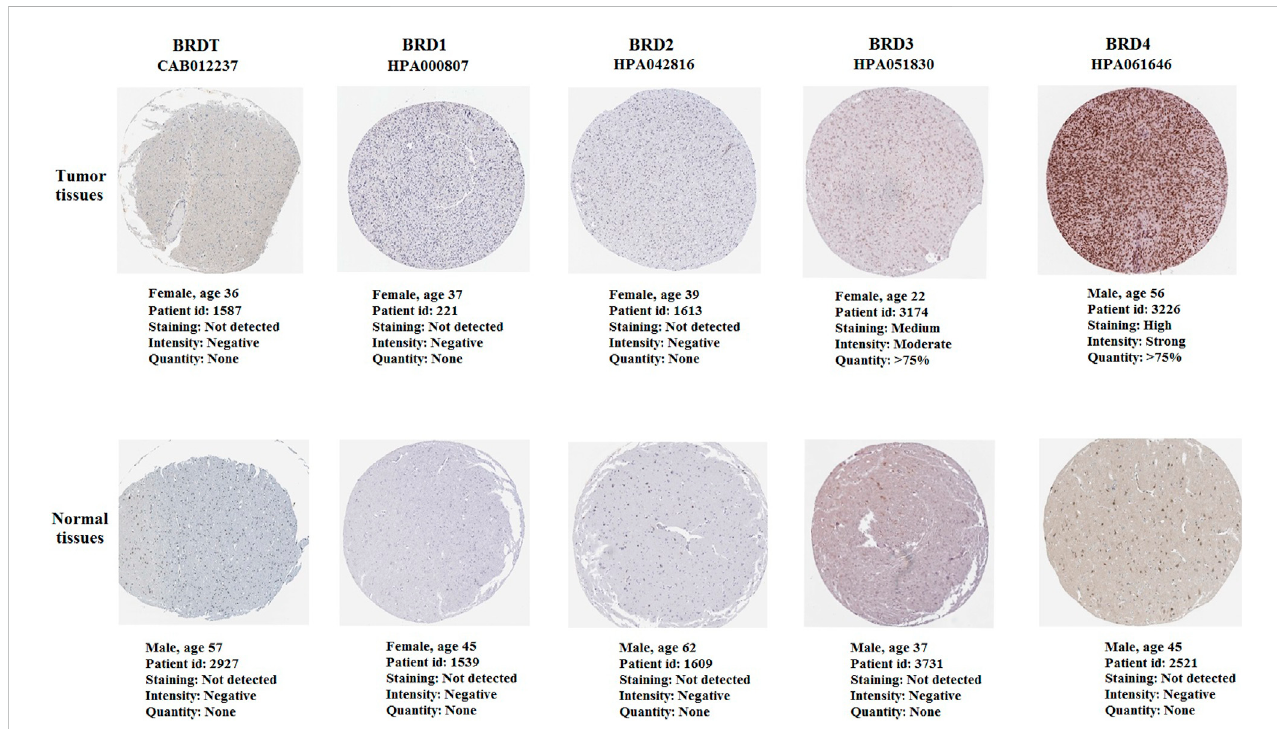
FIGURE 8 The immunohistochemistry of BET proteins in tumor tissues and normal cerebral cortex tissues (Scale bar: 200 μ m). The expression of BRD4 protein in tumor tissues was higher than that in normal